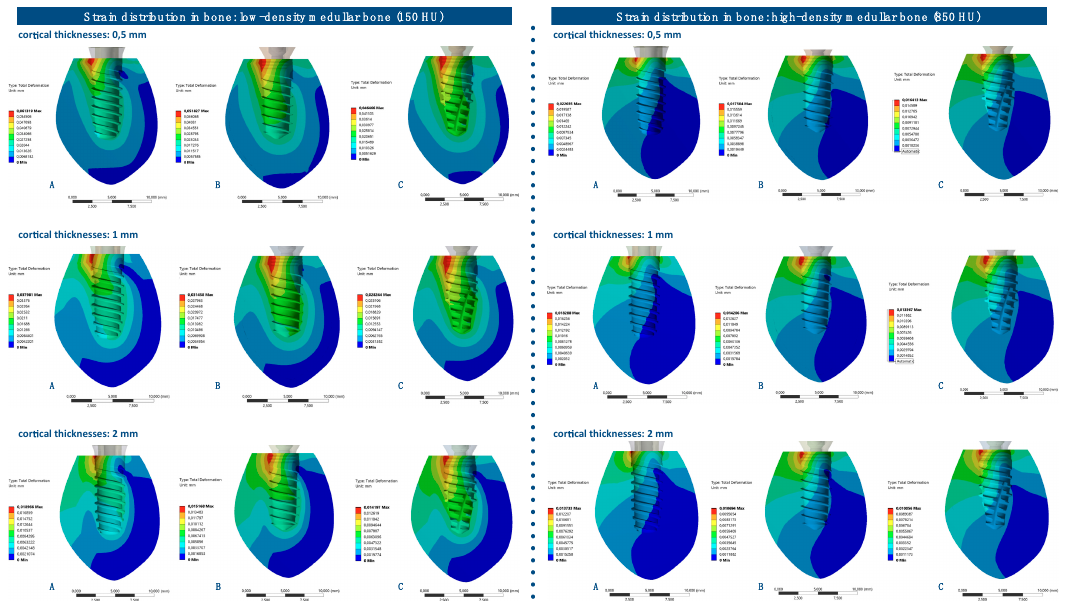
Figure 5. Strain distribution in bone for all implant designs: A, B, and C. Note: the figure is in very high resolution to be able to be enlarged: enlarge it in your word processor or view it in HTML format.